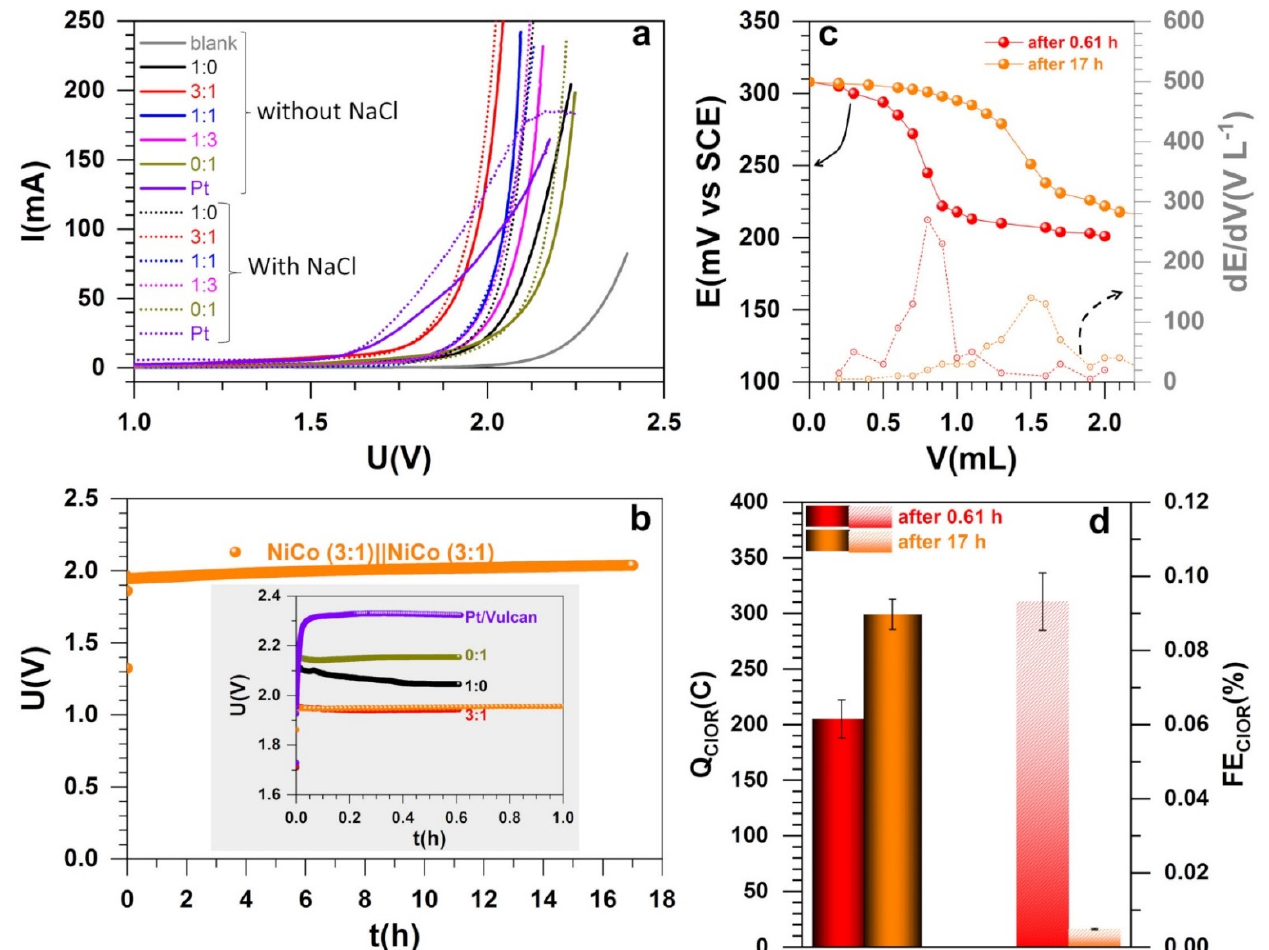
Figure 7. Two-electrode experiments: Water splitting realized at room temperature using the as-fabricated electrocatalysts (both at anode and cathode) through the ratio PANI-Ni:PANI-Co of 1:0, 3:1, 1:1, 1:3, and 0:1 based on atomic ratio of Ni:Co after calcination. ( a ) Polarization curves recorded at 0.005 V s − 1 in 1 M NaOH in the absence (solid) and presence (dotted) of 1 M NaCl. ( b ) Chronopotentiometry curve recorded at 100 mA using the electrocatalyst corresponding to PANI-Ni:PANI-Co of 3:1. ( c ) Two-electrode potentiometry at zero current for the iodide titration (20 mL: electrolysis solution + HCl + KI) by thiosulphate (1 mM). ( d ) Quantified oxidized chloride species by the potentiometry assays in terms of charge (left y -axis) and faradaic efficiency (right y -axis). Pt/Vulcan refers to commercial electrocatalyst. The support (blank) was a carbon paper electrode of 2 cm high and 2 cm wide—i.e., 8 cm 2 for both external surface.